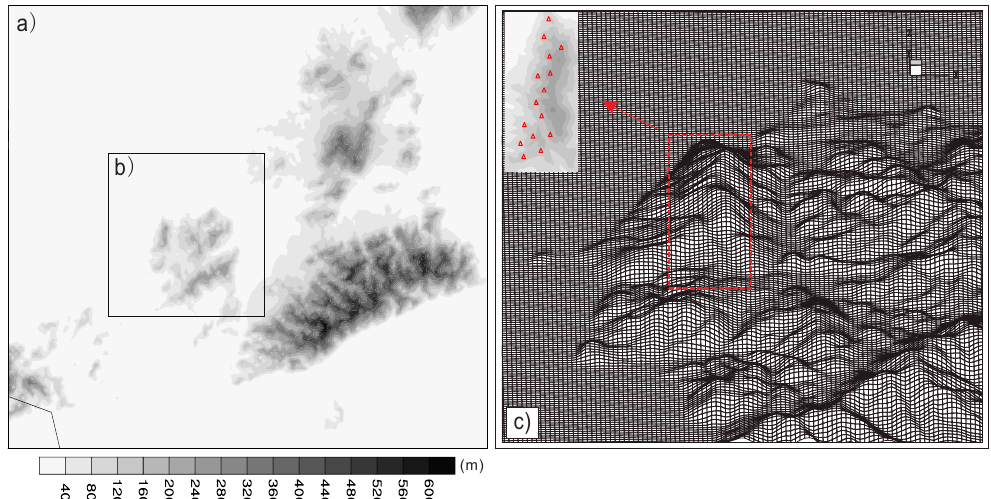
Figure 1. The configuration of inner most Weather Research and Forecasting (WRF) domain ( a ) and the OpenFOAM domain ( b ). The gray shaded indicates the terrain height. An enlarged part of the mesh structure of OpenFOAM domain is displayed in ( c ), where the wind farm of interest is included. The red triangles stand for the specific position of 15 turbine